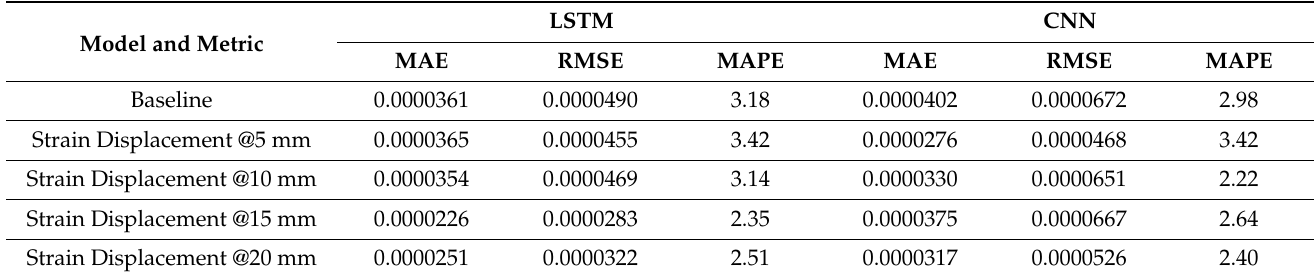
Table 7. Accuracy deep learning models for Sample